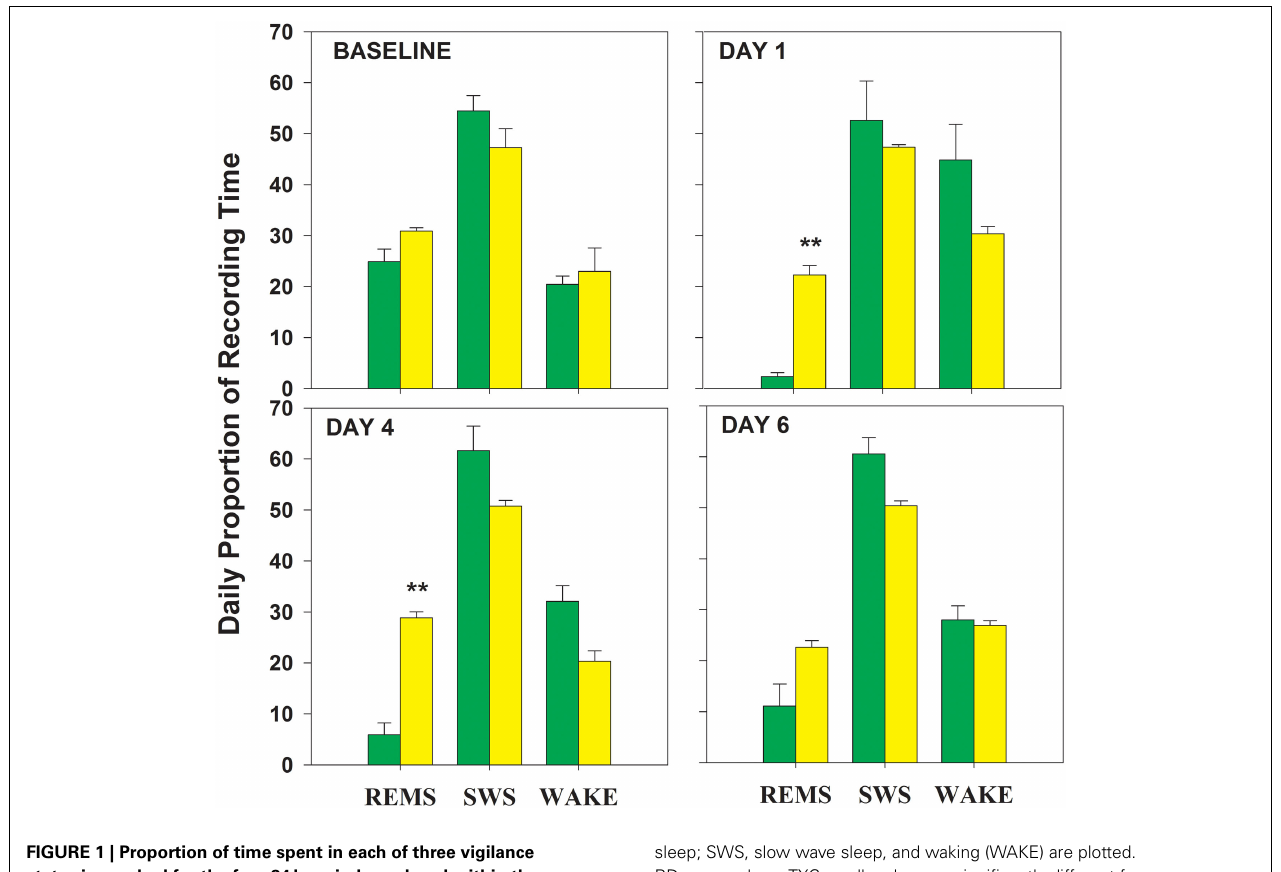
FIGURE 1 | Proportion of time spent in each of three vigilance states is graphed for the four 24h periods analyzed within the 8-day experimental protocol (baseline day and 7 shaker days). On each graph, the percent times spent in REMS, rapid eye movement